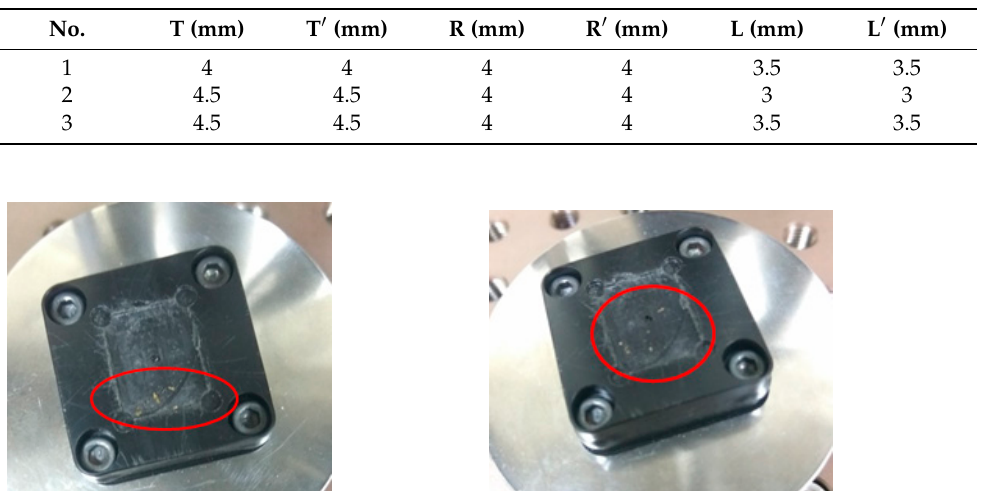
Figure 14. The compressive stress-strain curves of the gradient porosity structure. Table 12. Height of each observation point for specimens 1 to 3.